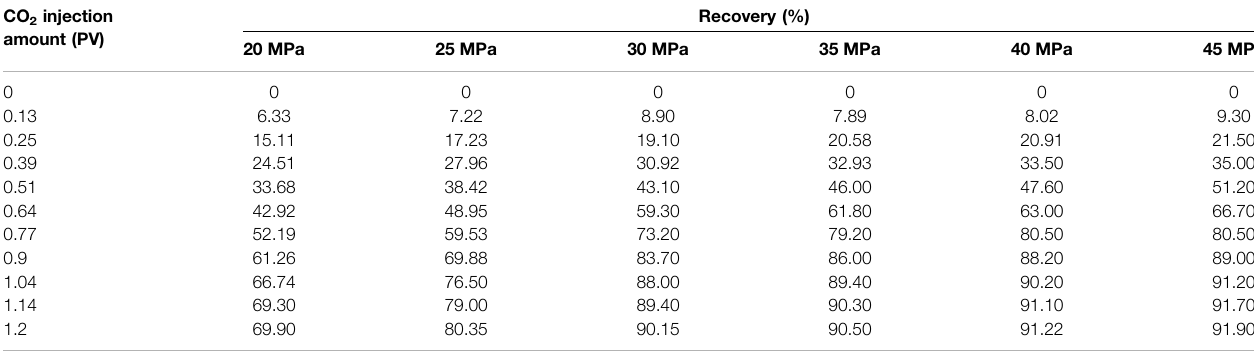
TABLE 3 | The long-slim-tube displacement experimental data under different pressures. CO 2 injection amount